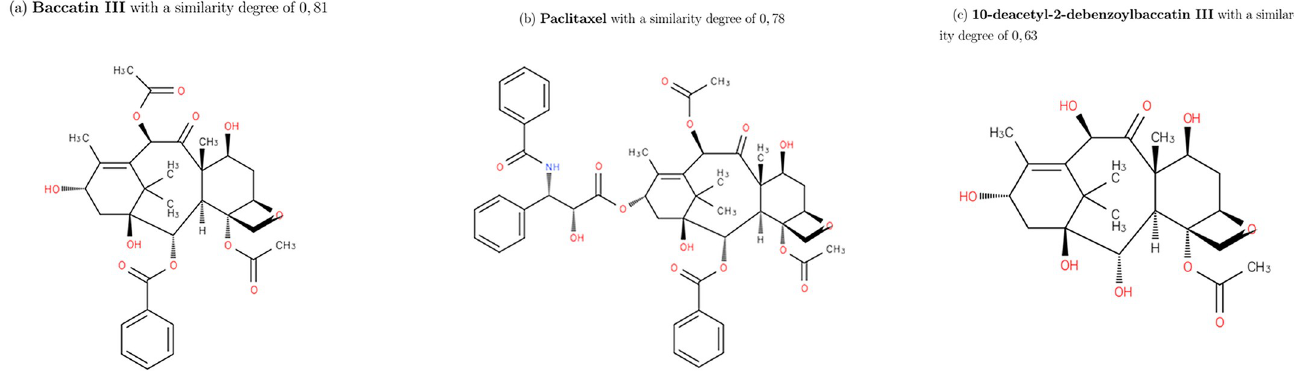
Fig 10. Three molecules similar to docetaxel with GC similarity. From left to right: (a) Baccatin III with a similarity of 0.81, (b) Paclitaxel with a similarity of 0.78 and (c) 10-deacetyl-2-debenzoylbaccatin III with a similarity of 0.63.